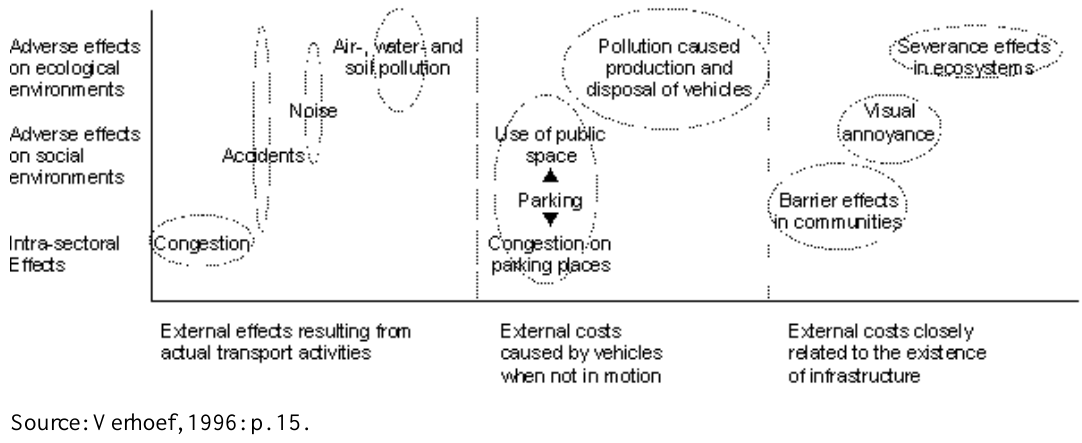
Figure 1. Typology of external costs of road